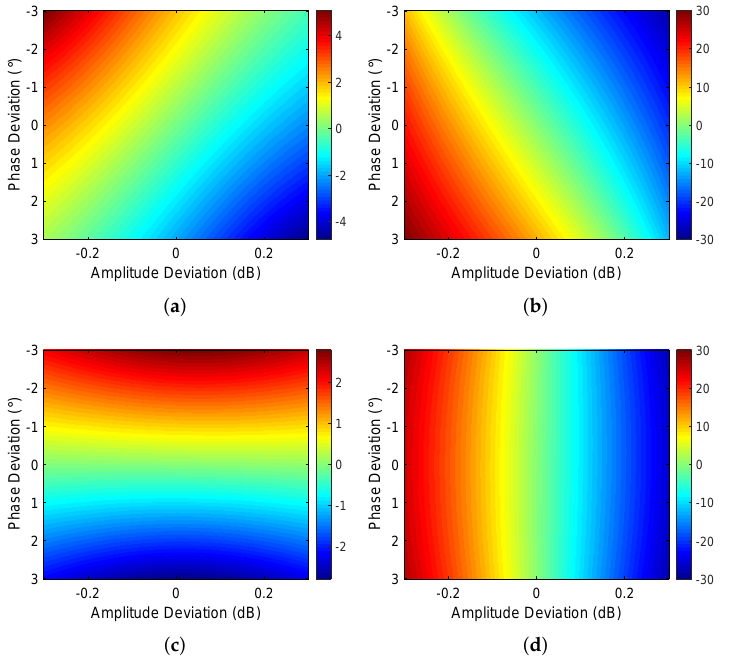
Figure 1. The impact on the estimation accuracy of channel imbalance parameters when the amplitude and phase coefficients of the CR-measured scattering vectors are inconsistent. The first and second row respectively represent the results when trihedral or dihedral is the “inconsistent” CR. ( a , c ) are estimation errors for amplitude imbalance (dB). ( b , d ) are estimation errors for phase imbalance ( ◦